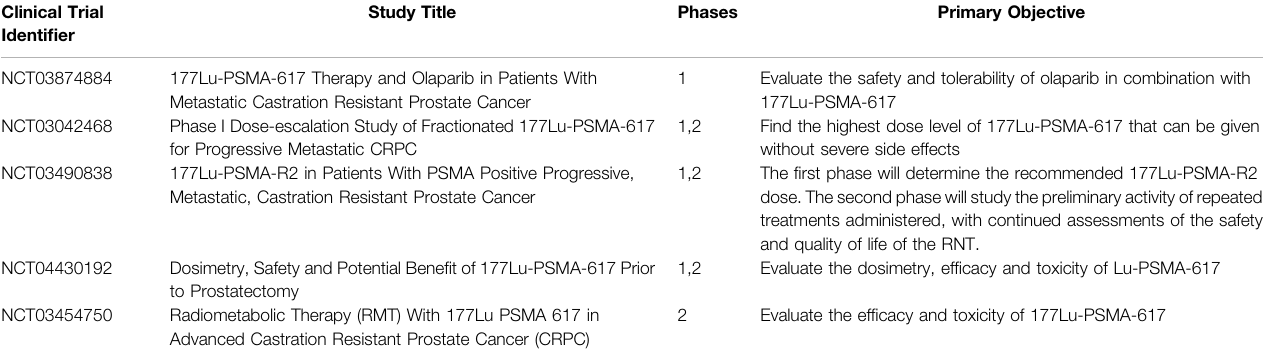
TABLE 1 | Summary of ongoing clinical trials for 177Lu-PSMA RNT. Clinical Trial Identi fi er